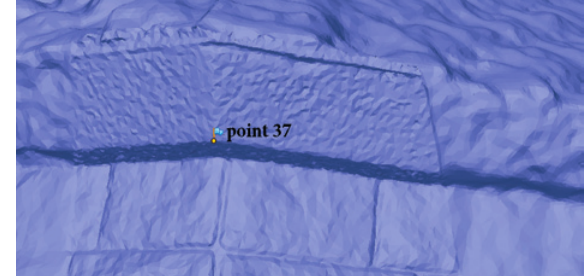
Fig. 7. Visualisation of accuracy differencies between parts of 3D models made from images shot at various distances from the object